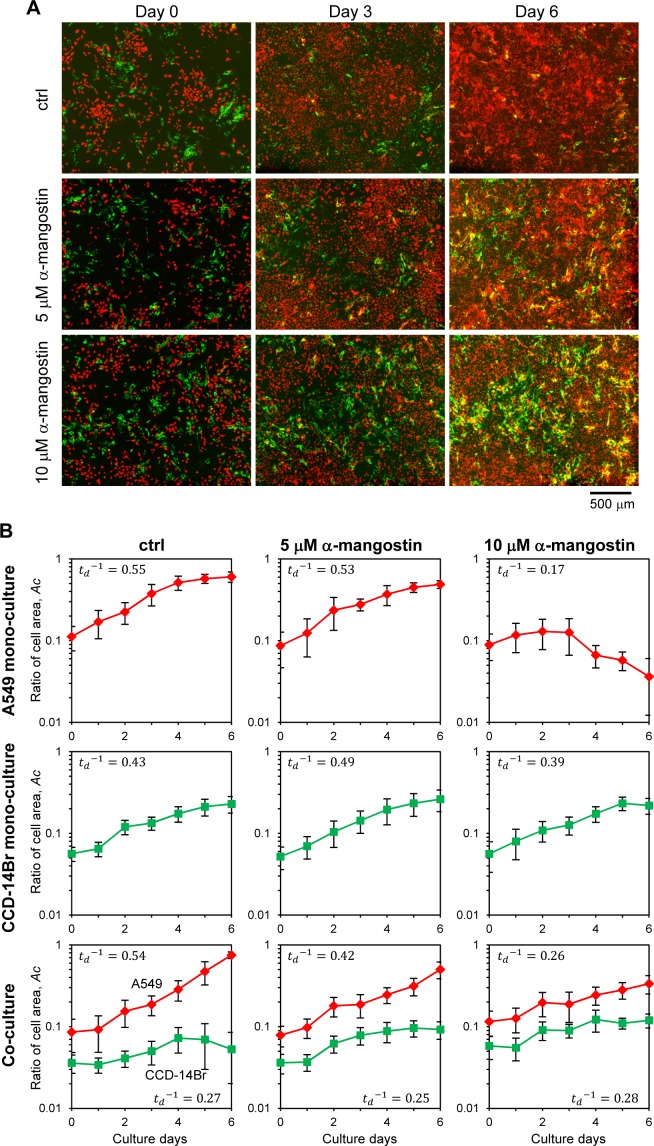
Invasion of cancer A549 to CCD-14Br cells in co-culture conditions treated with α-mangostin.Cells were cultured in co-culture or monoculture condition, then exposed with or without α-mangostin. (A) Fluorescence images of co-cultured cells. A549 cells were labeled with red fluorescence and CCD-14Br cells were labeled with green fluorescence. (B) Ratio of each cell area, Ac, cultured in monoculture or co-culture with A549 and CCD-14Br cells. The cell area was calculated from more than seven fluorescence images in each condition. Inverse value of the doubling time of each culture condition, \documentclass[12pt]{minimal}
\usepackage{amsmath}
\usepackage{wasysym}
\usepackage{amsfonts}
\usepackage{amssymb}
\usepackage{amsbsy}
\usepackage{upgreek}
\usepackage{mathrsfs}
\setlength{\oddsidemargin}{-69pt}
\begin{document}
}{}${t}_{d}^{-1}$\end{document}td−1 (d−1) is shown in each graph.